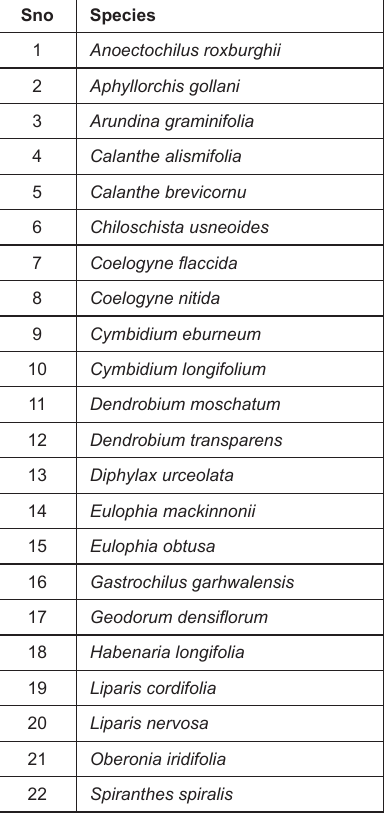
Table 1. List of doubtful